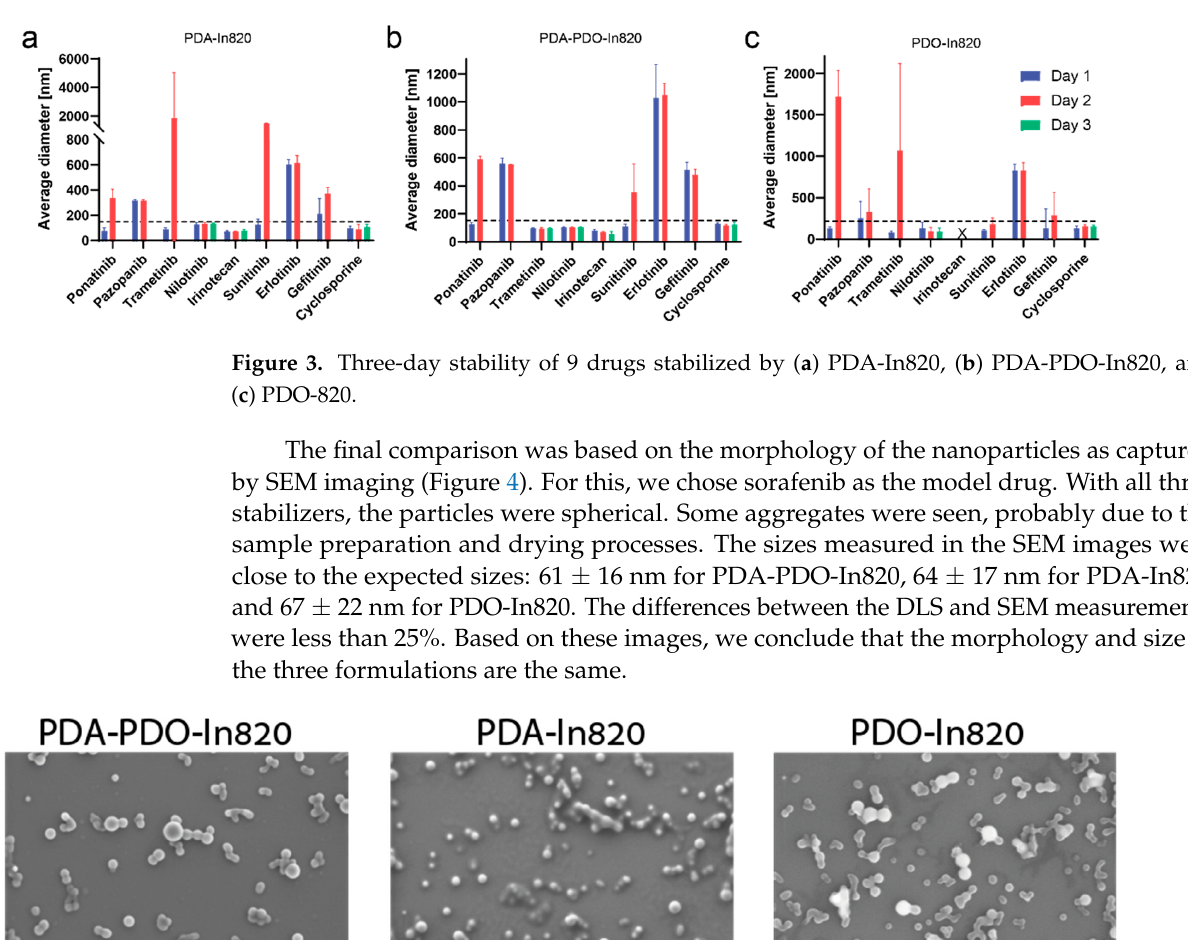
Figure 2. Selection of top copolymer. ( a ) Left comonomers matrix, illustration of colors after a 4 h reaction in sodium bicarbonate buffer 0.1 M. Right-normalized confluence of blue emission at 477 nm with nilotinib. ( b ) Average diameter of sorafenib and nilotinib nanoparticles formulated with different polymers. ( c ) Polydispersity index (PDI) of nanoparticles made with different copolymers. ( d ) Stabilization over time of nilotinib nanoparticles formulated with different stabilizers.